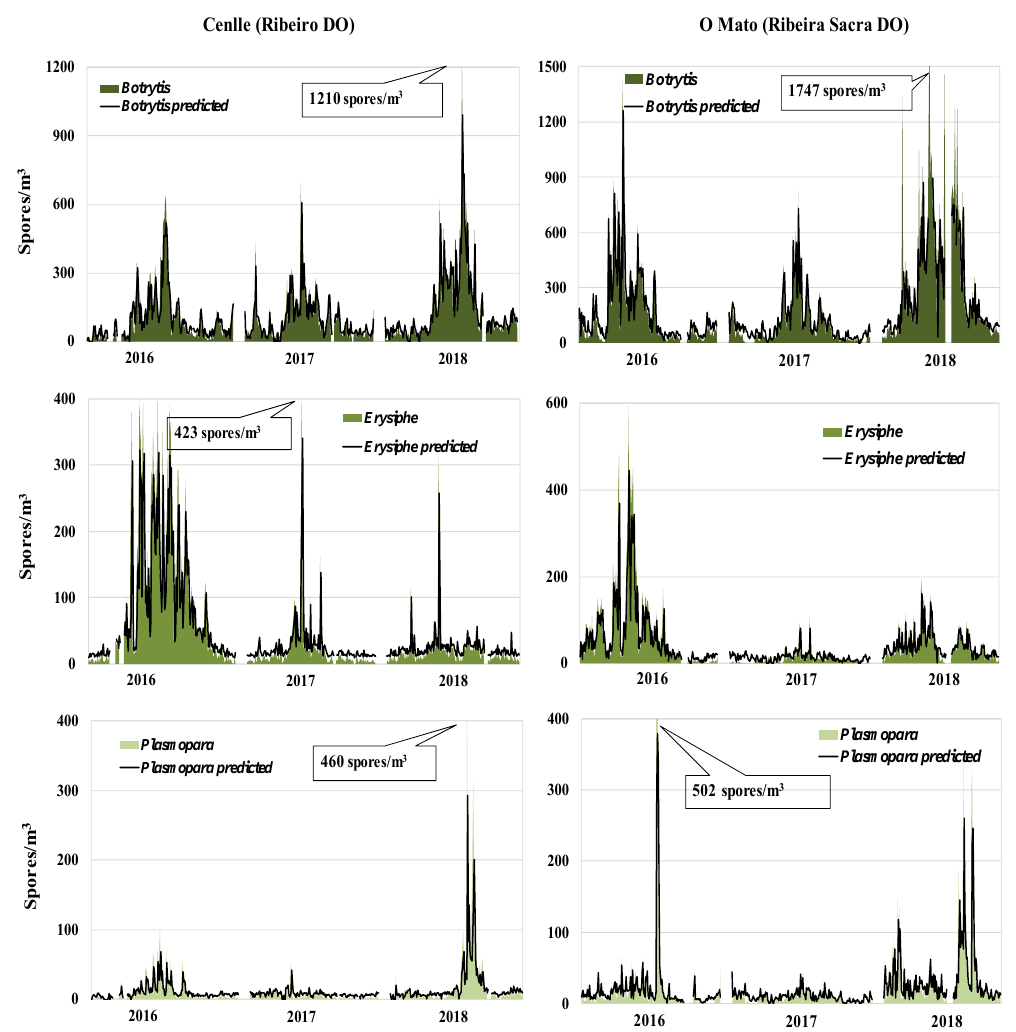
Figure 4. Observed and predicted Botrytis , Erysiphe , and Plasmopara spore concentrations during the 2016 − 2018 period, in both vineyards (Cenlle and O Mato).